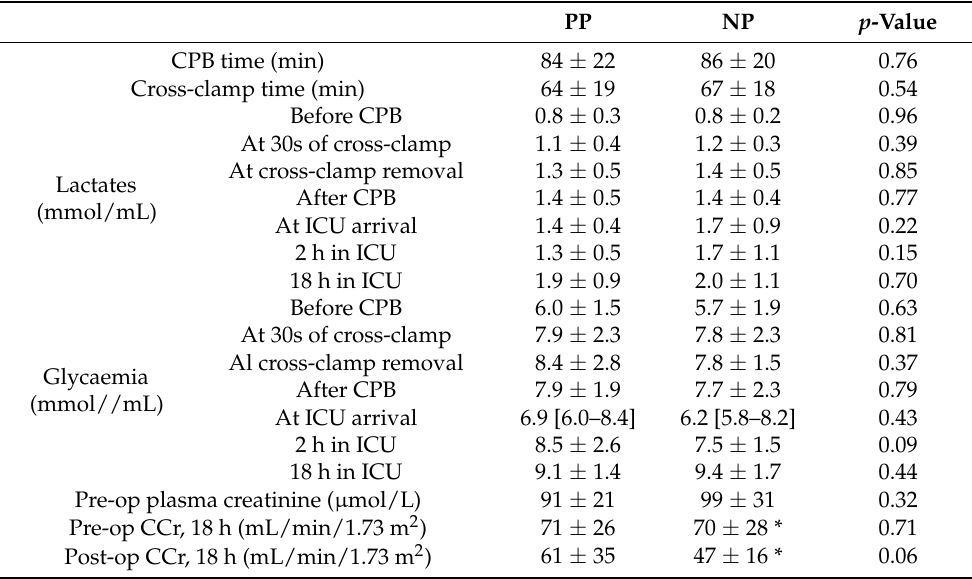
Table 4. CPB-time, cross-clamp time and perioperative profiles of lactates, glycaemia, creatinine